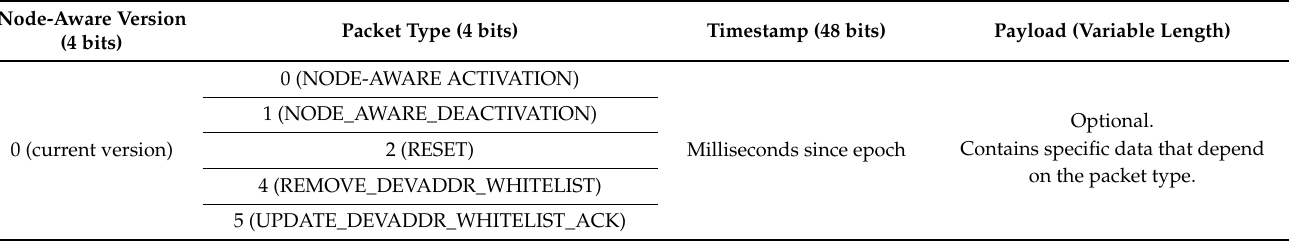
Table 1. Structure of the command